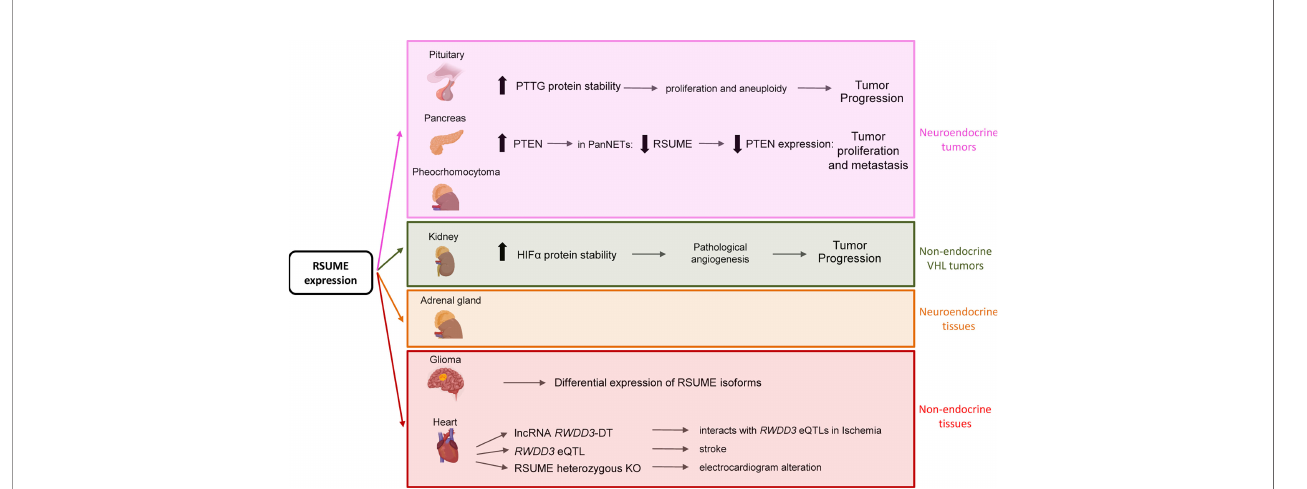
FIGURE 2 | Summary of RSUME actions in neuroendocrine or non-endocrine tissues and tumors. RSUME is expressed and acts in normal and tumoral tissues. Of particular interest are those tissues in which it is highly expressed, such as pituitary, pancreas, kidney, brain and heart, where it exerts different functions through the interaction with the indicated key factors. Interestingly it is also expressed at high levels in normal and tumoral (pheochromocytoma) adrenal gland, a VHL type of tumor, in which its functions remain to be